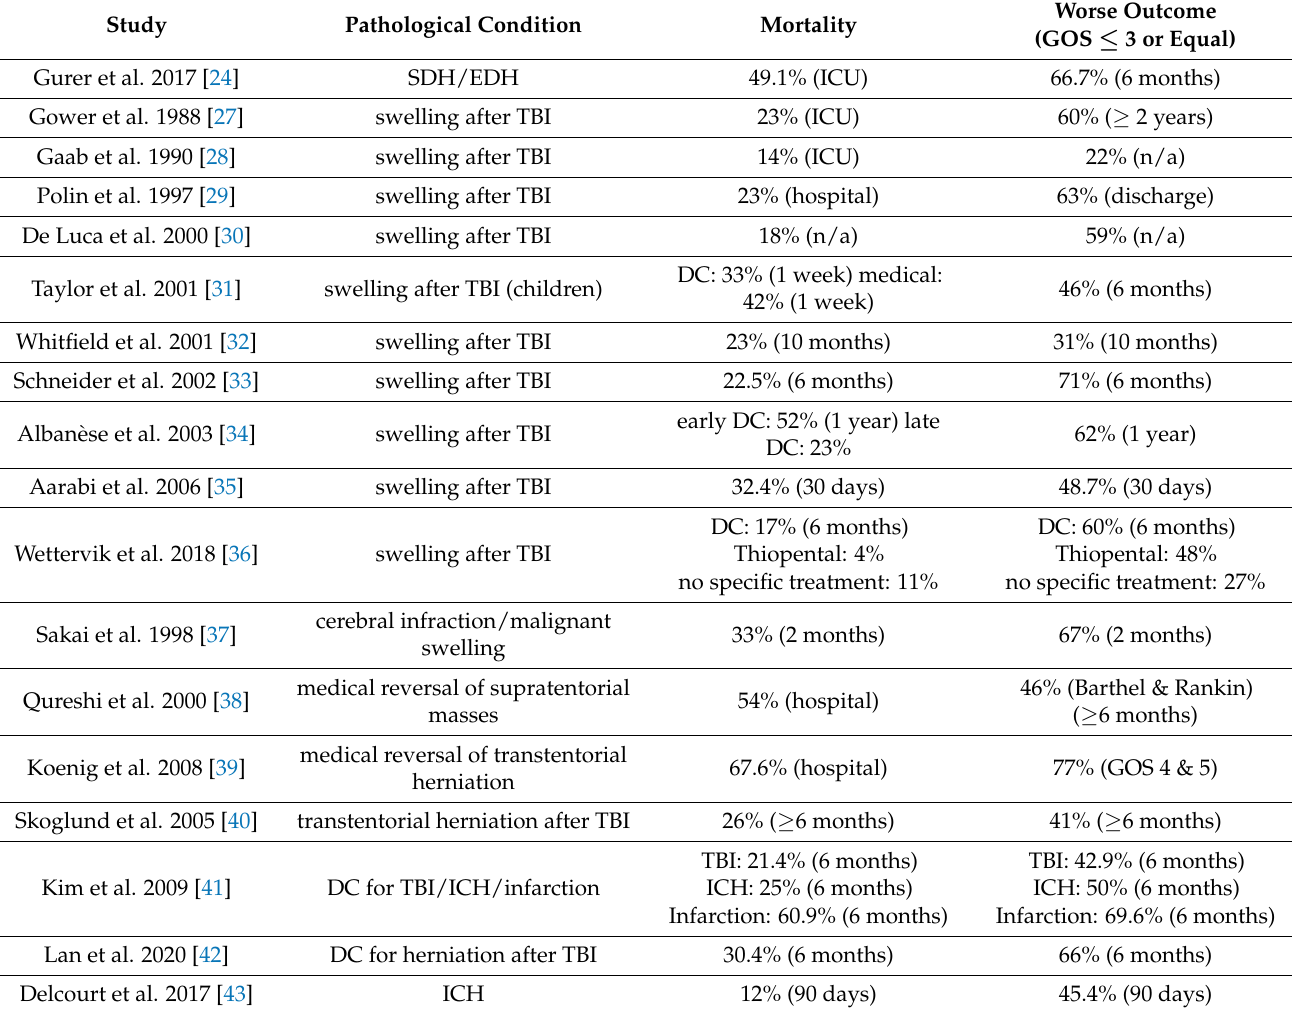
Table 1. Outcome of different intracranial pathologies leading to intracranial hypertension. Abbreviations: GOS =